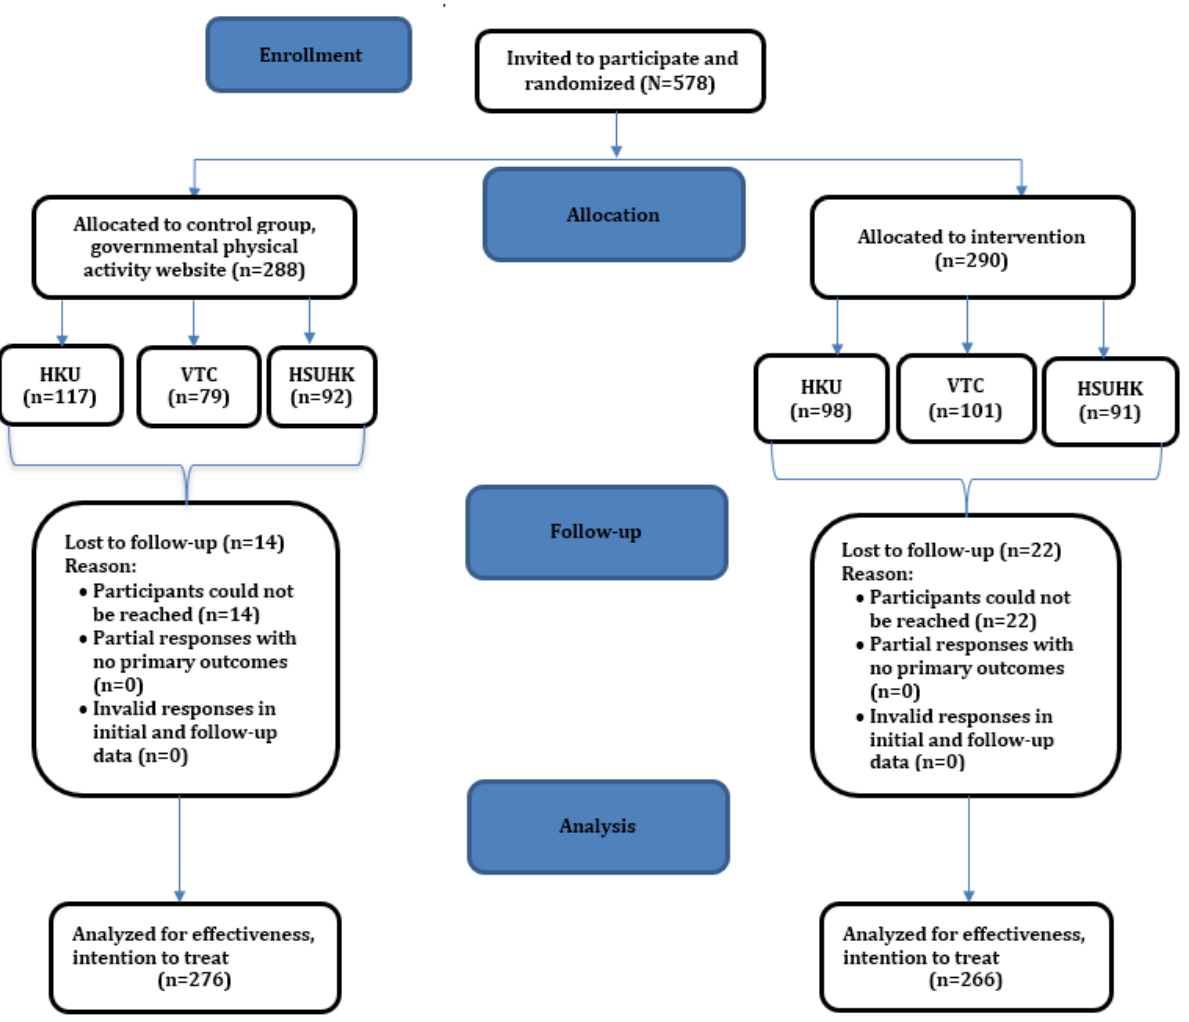
Figure 2. CONSORT flow diagram. HKU: University of Hong Kong; HSUHK: Hang Seng University of Hong Kong; VTC: Vocational Training